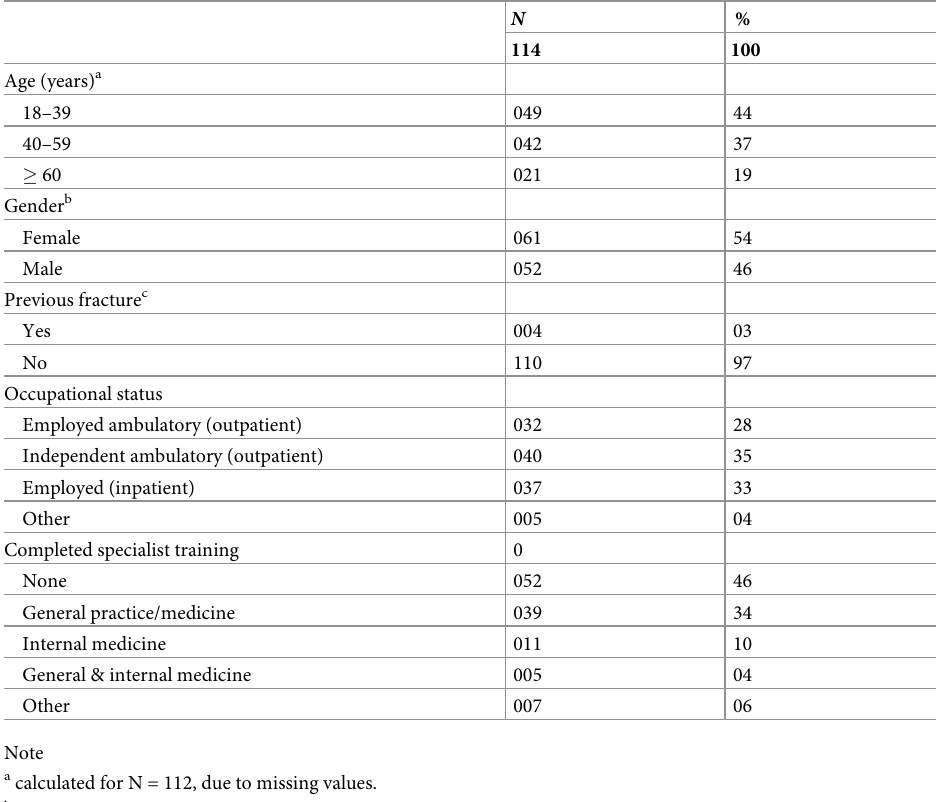
Table 1. Demographic characteristics of